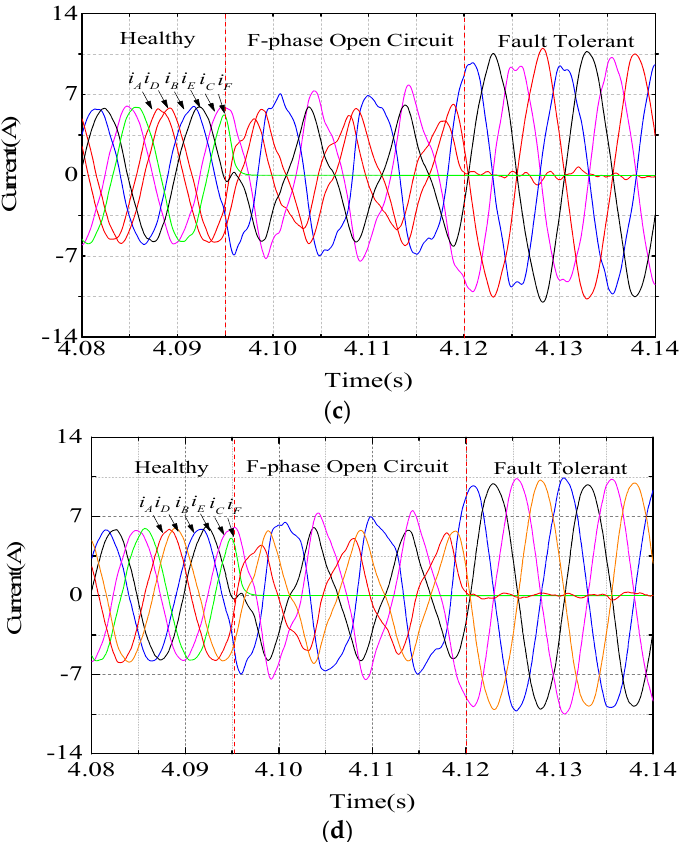
Figure 13. Motor healthy, fault and fault-tolerant currents. ( a ) Fault-tolerant control with optimal objective of the traditional MCC. ( b ) Fault-tolerant control with optimal objective of the proposed MCC. ( c ) Fault-tolerant control with optimal objective of the traditional MTO. ( d ) Fault-tolerant control with optimal objective of the proposed MTO.